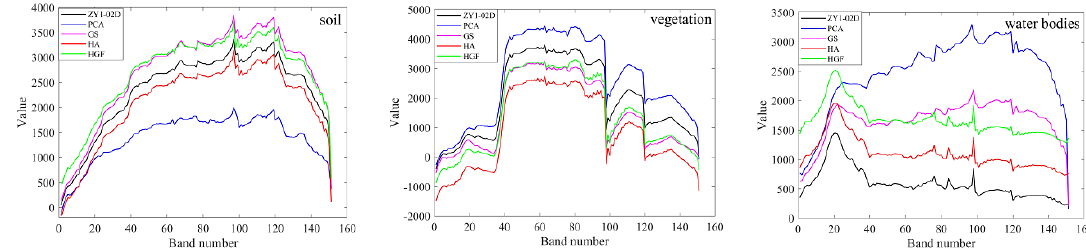
Figure 6. Preprocessed images ( a ), ( b ) and fused images obtained through ( c ) GS, ( d ) PCA, ( e ) HA, and ( f ) HGF.